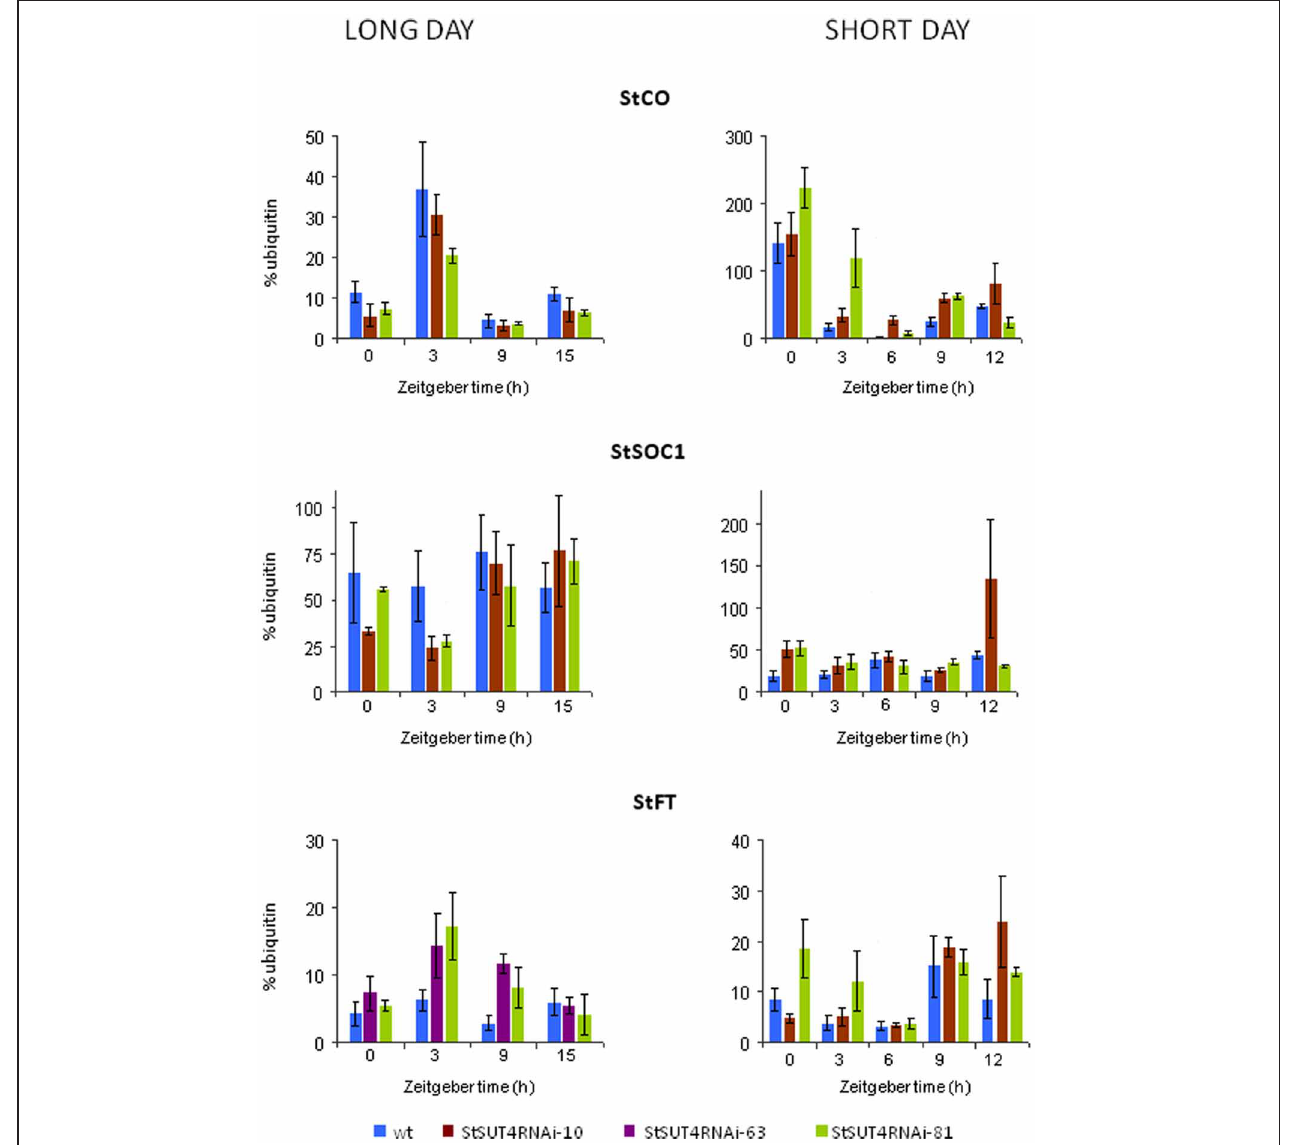
FIGURE 5 | Quantification of the transcript levels of circadian-regulated gene StFT, StSOC1 , and StCO via reverse transcription real time PCR in leaves of Solanum tuberosum Désirée plants. Potato plants were grown either under short day (10h light with a light period from 8a.m. to 6p.m.) or long day (16h light with a light period from 6a.m. to 10p.m.) conditions. StCO and StSOC1 mRNA accumulation is reduced in StSUT4 -inhibited plants